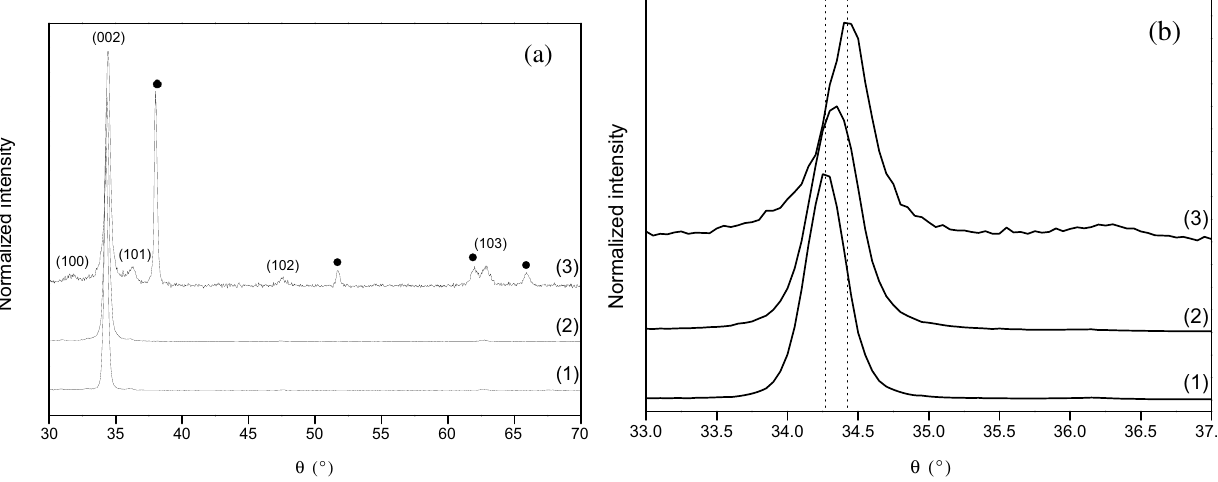
Fig. 2. (a) XRD pattern of ZnO:Al substrate (1), nanoporous ZnO electrodeposited on ZnO:Al (2) and nanoporous ZnO deposited on FTO glass (3). Dashes on (3) correspond to peaks characteristic of SnO 2 . (b) Enlargement of the 002 peak area.